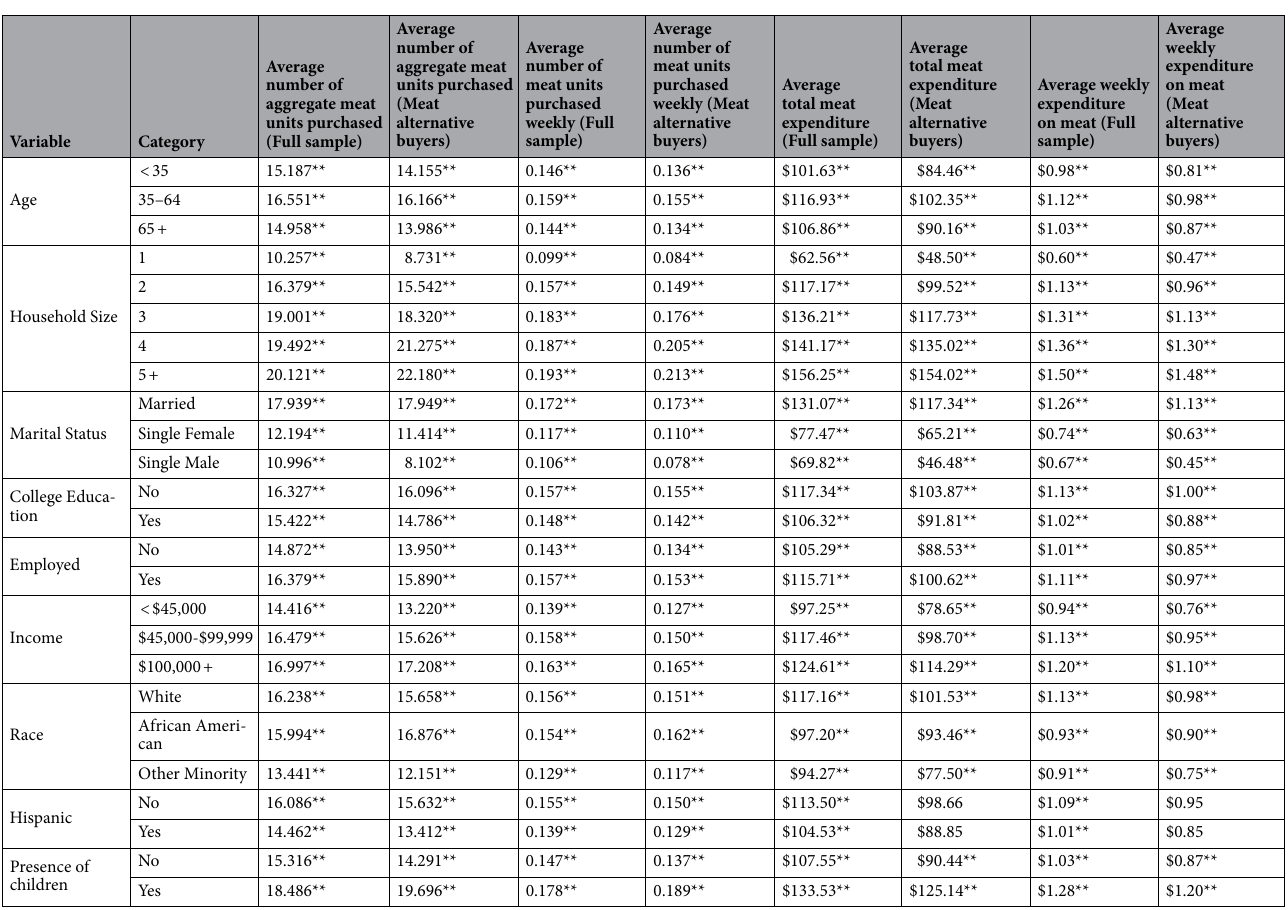
Table 4. Ground meat units purchased and expenditure by demographic categories. ANOVA tests were used to examine if the difference in mean values of each metric between demographic categories were different from 0. The sample used for the statistical test is denoted in parenthesis in the column description. A * denotes significance at the 5% level and ** denotes significance at the 1%